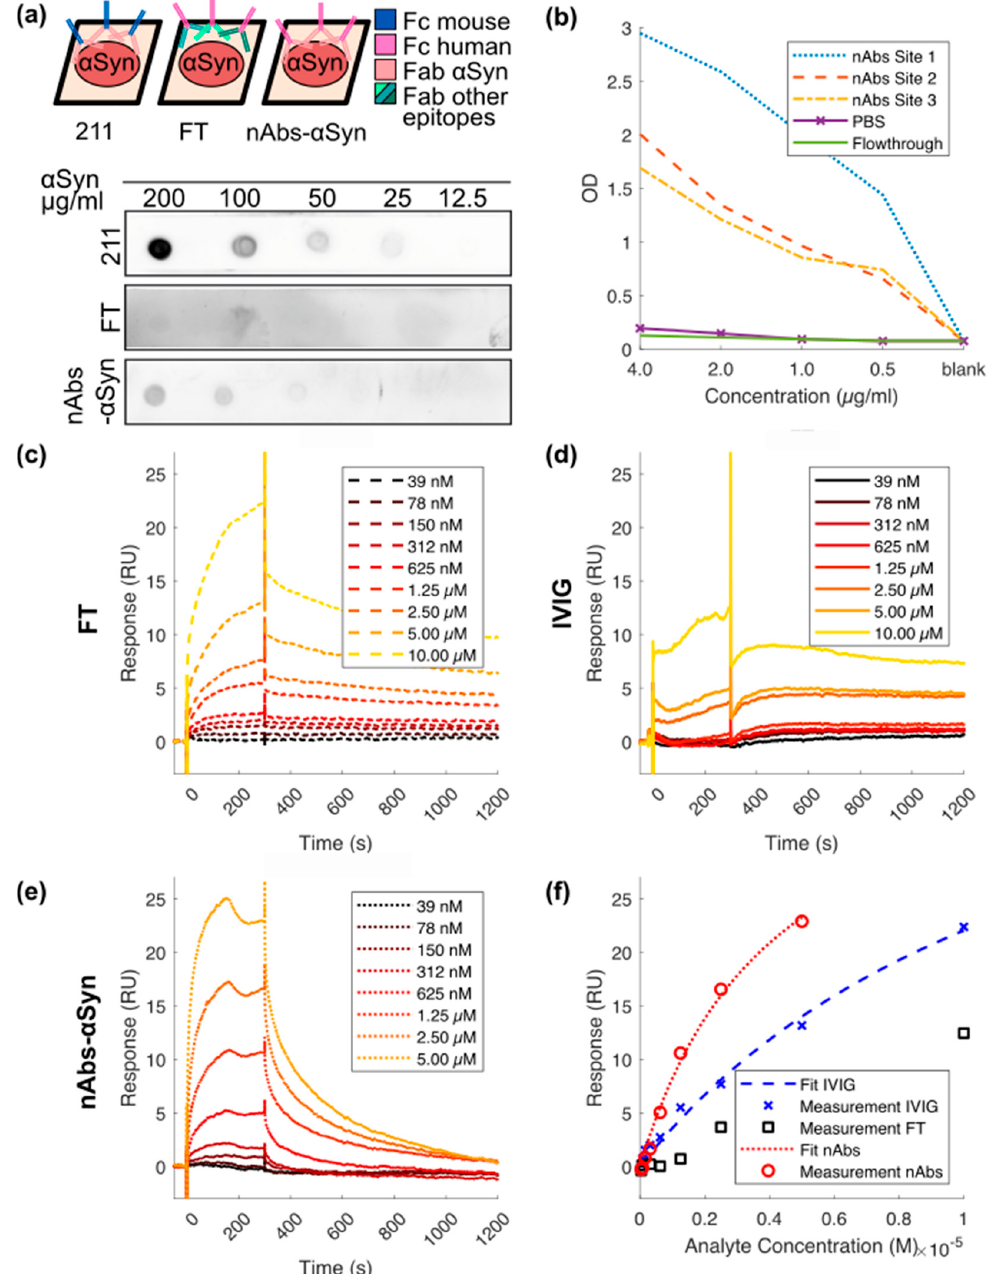
Figure 1. Binding characteristics of nAbs- α Syn in dot blot, ELISA, and SPR. ( a ) nAbs- α Syn recognize α Syn on a dot blot: α Syn at different concentrations were spotted on a nitrocellulose membrane and then probed with flow through and nAbs- α Syn. Anti- α Syn antibody was used as a control. Although the control antibody (211) is a mouse antibody, FT and nAbs- α Syn are of human origin (see sheme). Each dot blot requires a different secondary antibody (either anti-mouse or anti-human) ( b ) nAbs- α Syn recognize α Syn in an ELISA: nAbs- α Syn from three different project sites were tested in an ELISA, to determine their capacity to bind to α Syn in vitro. ( c – f ) nAbs- α Syn recognize α Syn in SPR: SPR curves of nAbs- α Syn ( e ) binding to recombinant α Syn. IVIG (c) and FT ( d ) were used as controls. A concentration range of 39 nM–5 μ M of nAbs- α Syn was applied in SPR. The binding affinity was determined from three replicates.